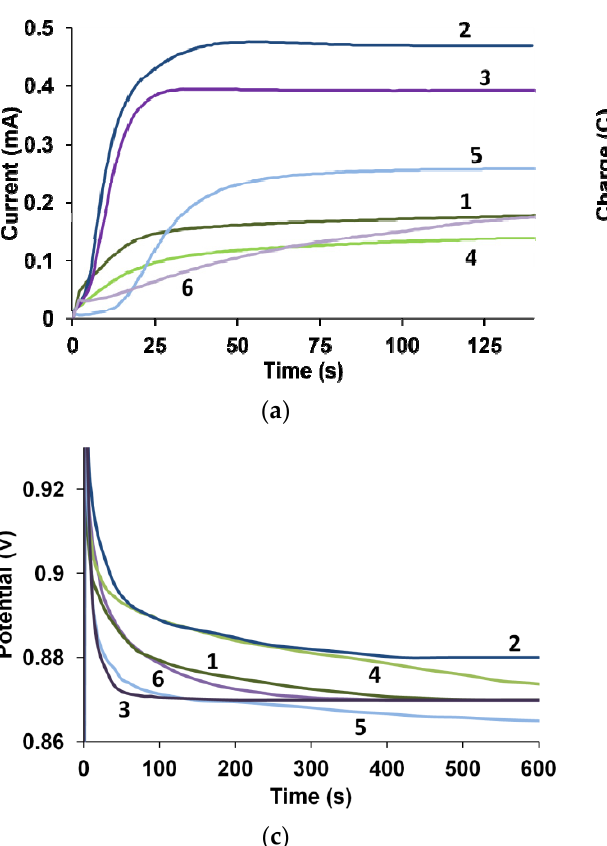
Figure 3. Kinetic curves of current ( a ) and charge ( b ) obtained during PS synthesis and potential ( c ) obtained during GS synthesis in presence of PAMPSA (1), t-PASA (2), PAMPSA/t-PASA (1:1) (3), PAMPSNa (4), t-PASNa (5), PAMPSNa/t-PASNa (1:1) (6).